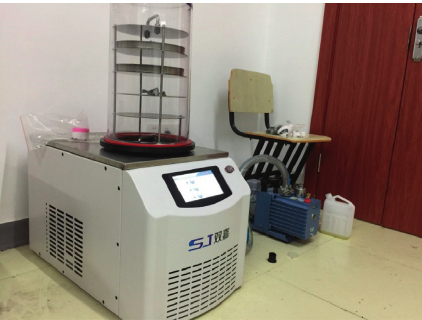
Figure 3: Lyophilizer with a vacuum